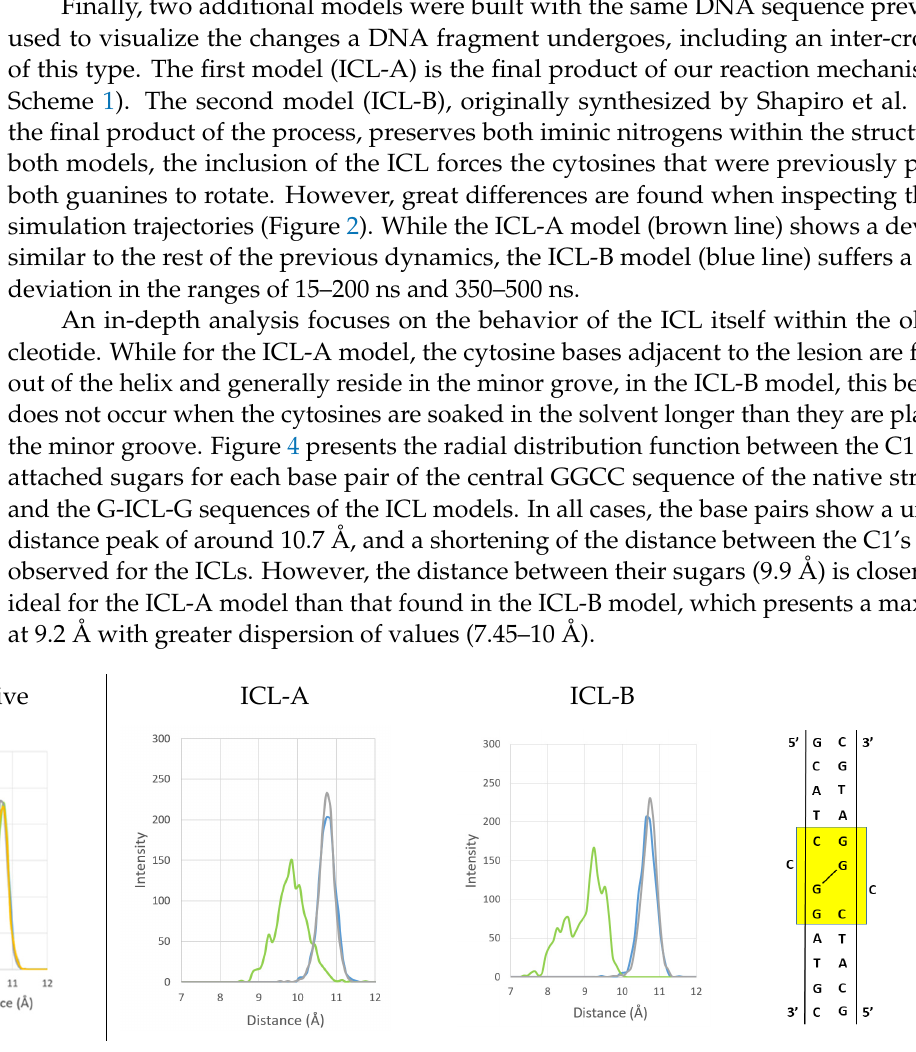
Figure 4. Histograms of distances between the C1’ of the attached sugars for each base pair of the central GGCC sequence (yellow square) of the native structure and the G-ICL-G sequences of the ICL-A and ICL-B models presented during the MD simulations.